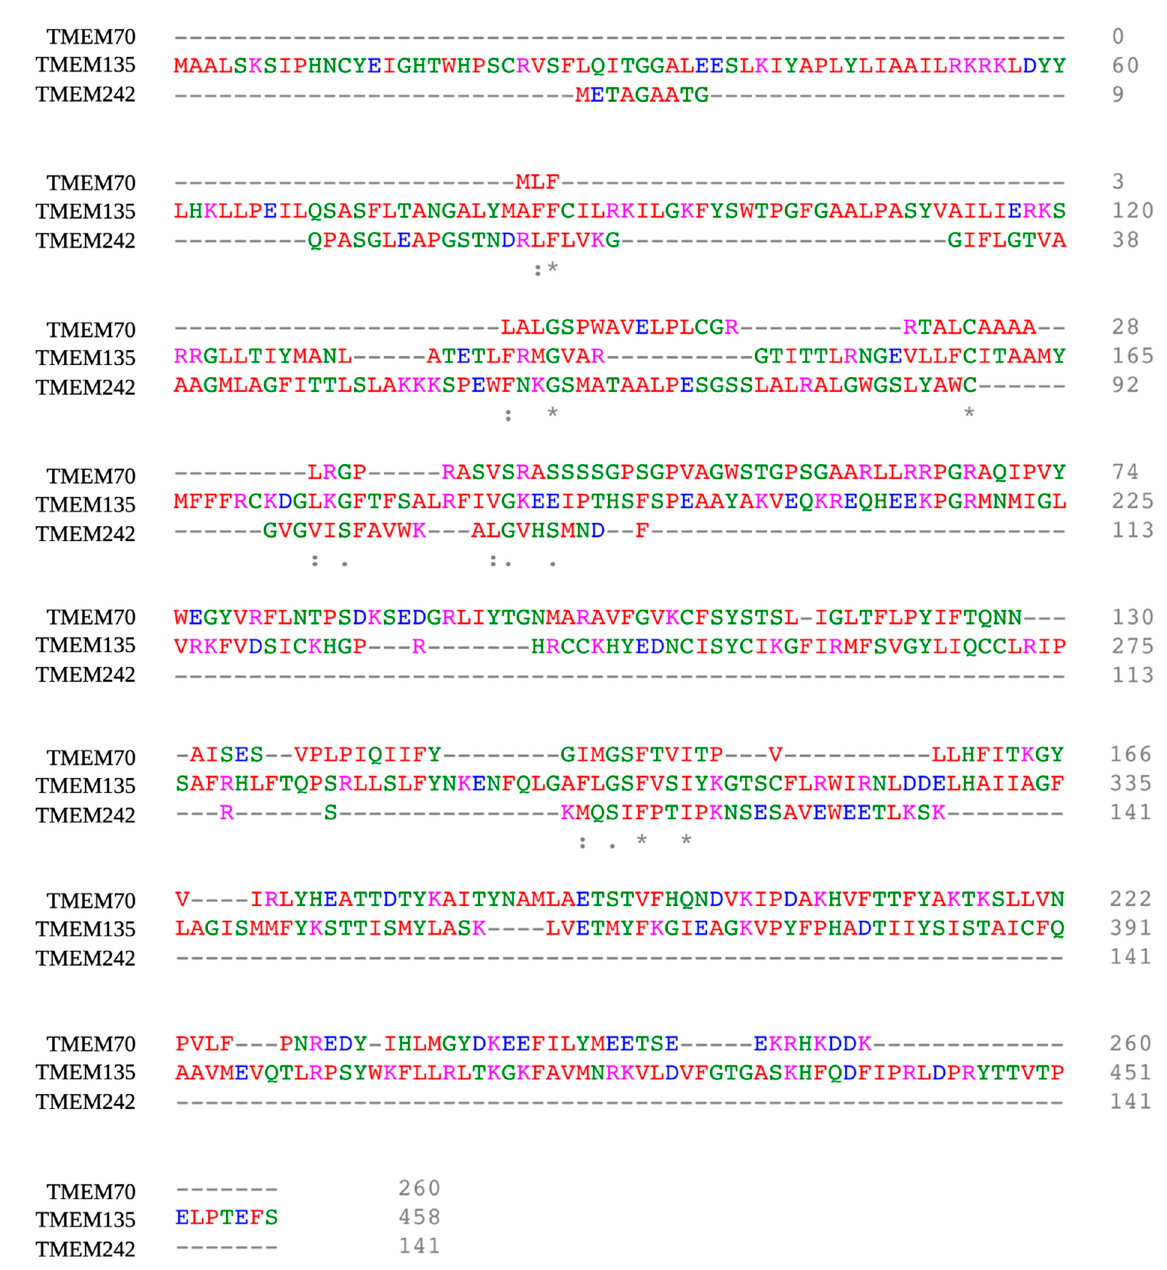
Figure 2. Comparison of the conserved sequence homology of TMEM135 ( homo sapien ) [NP_075069.3] with TMEM70 ( homo sapien ) [AAH02748.2] and TMEM242 ( homo sapien ) [NP_060922.2] using Clustal Omega Multiple Sequence alignment (v.1.2.4.) [36]. Clustal Omega designates the following colors for amino acid groups: AVFPMILW-Red: Small (small + hydrophobic [includes aromatic –Y])DE-Blue: Acidic, RHK-Magenta: Basic -H,STYHCNGQ -Green: Hydroxly + sulfhydryl + amine + G Others-Gray: Unusual amino/imino acids, etc. Figure created with BioRender.com (accessed on 15 June 2021).